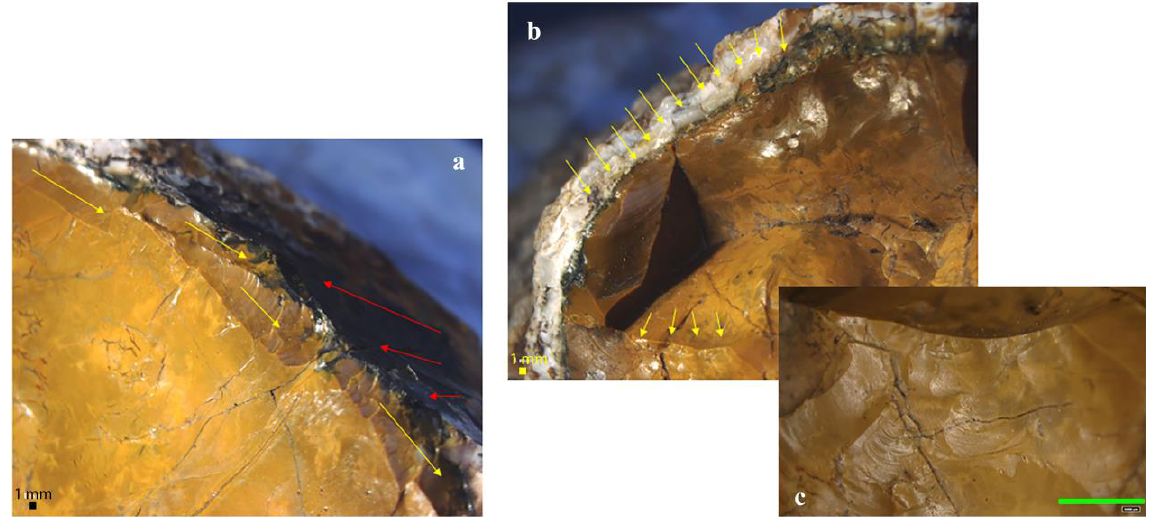
Figure 19. Lojanik 1, Cluster 1, sample 13, possible human extraction of raw material: a) three to four flake negatives from the same direction and three negatives from the cortex to the edge, scale bar equal to 1mm; b) possible human processing, scale bar equal to 1mm c) possible human processing (detail), scale bar equal to 2000